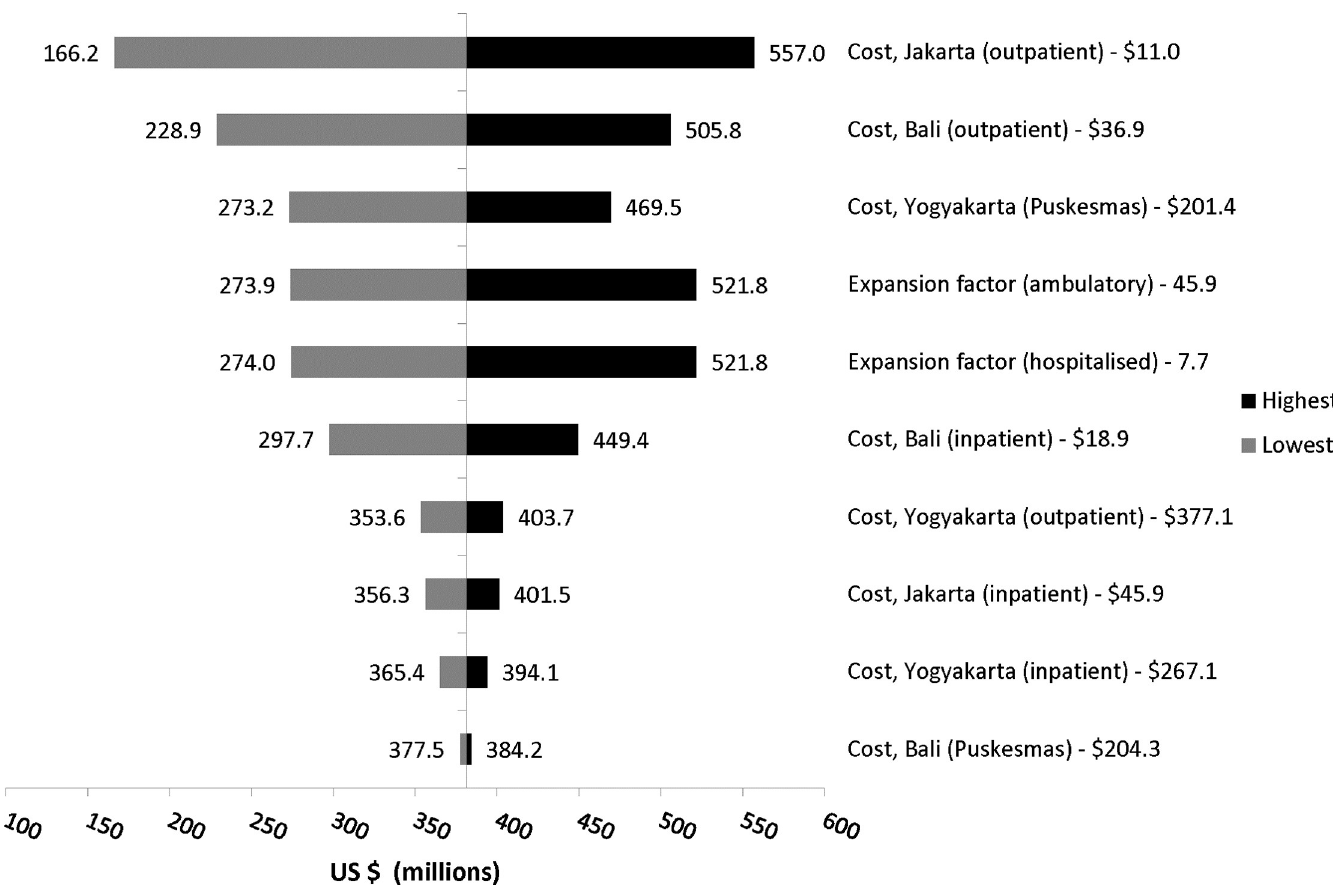
Fig 1. Tornado diagram for the deterministic sensitivity analysis of variability of the Indonesian national-level, annual cost of dengue illness in US$ million. Black represents the lowest value, grey represents the largest value. Parameters were varied by ± 10% as a subjective scenario and the base case was US$381.15 million. The point estimate for each parameter is included in the label for each